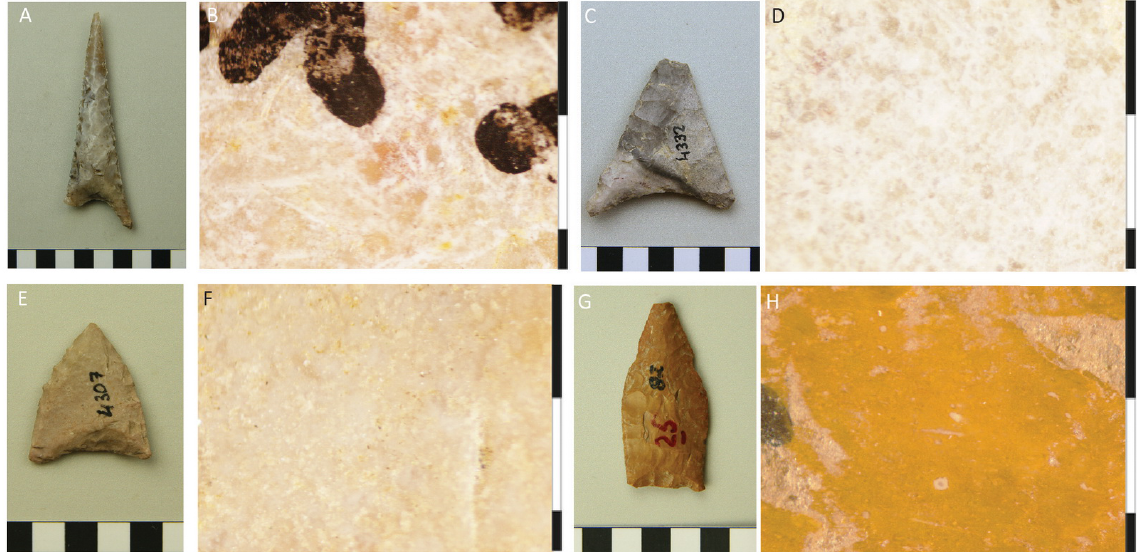
Figura 10. Microfácies 3: 10A e B; Microfácies 4: 10C e 10D; Microfácies 6: 10E e 10F; Microfácies 7: 10G e 10H. Figure 10. Microfacies 3: 10A and B; Microfacies 4: 10 and 10D; Microfacies 6: 10E and 10F; Microfacies 7: 10G and 10H.